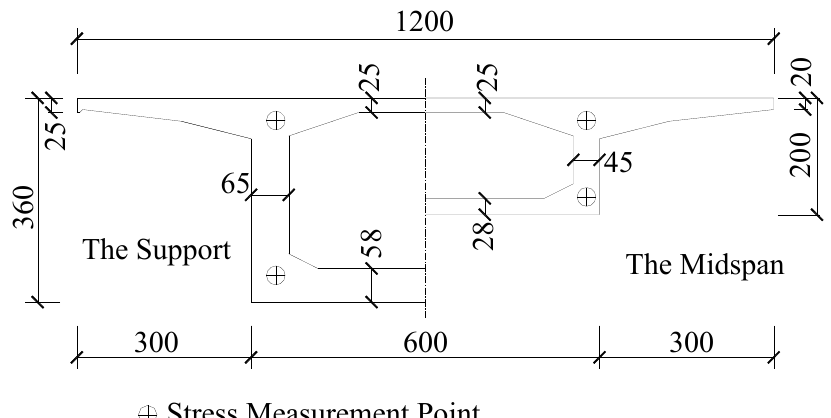
Figure 2. Cross ‐ section sketch of Huangsha Harbor Bridge (unit: cm). Figure 2. Cross-section sketch of Huangsha Harbor Bridge (unit: cm).